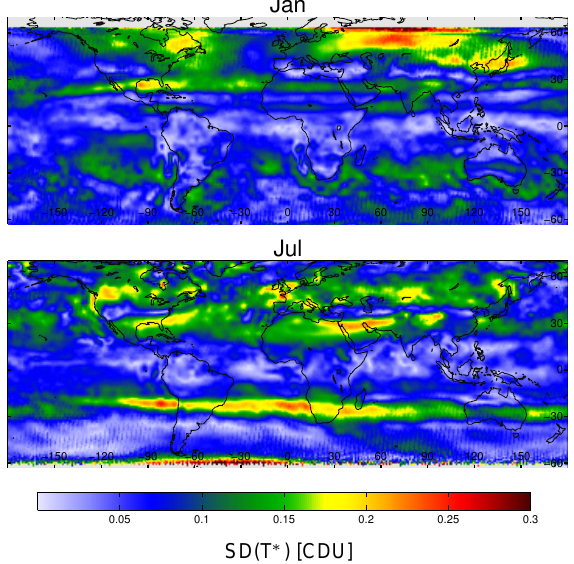
Figure 18. Standard deviation of monthly mean T ∗ from different algorithms (STREAM, DOMINO, NASA, and STS EMAC ) for Jan- uary (top) and July (bottom) 2005